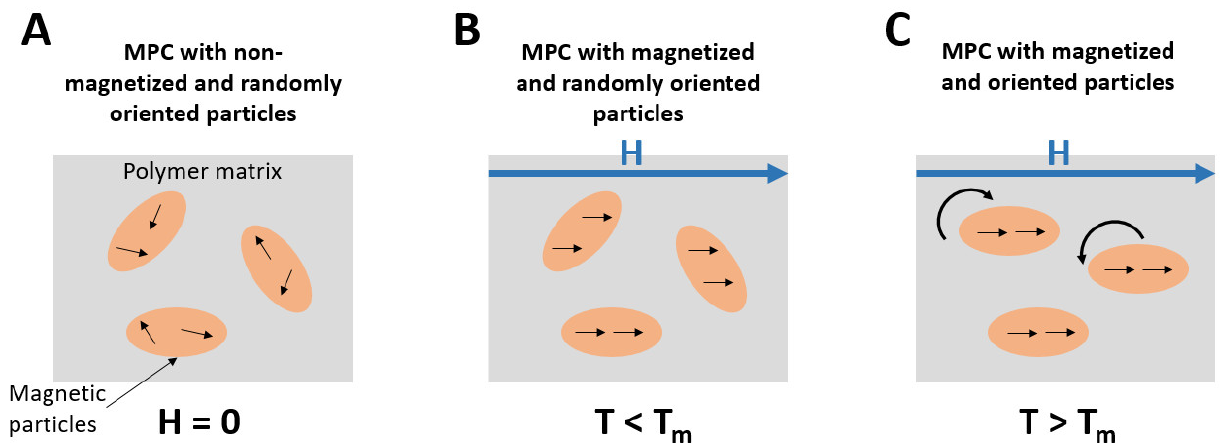
Figure 1. Orientation of the magnetic particles in the MPC under different conditions: ( A ) randomly oriented particles embedded in the polymeric matrix without any applied field (H = 0) and temperature under the melting temperature of the polymer (T m ); ( B ) when an magnetizing field strong enough (H > H s ) is applied and the temperature is under the melting temperature of the polymer, the particles are magnetized but not oriented; ( C ) when a strong enough magnetizing field (H > H s ) is applied and the temperature is over the melting temperature of the polymer, the particles are magnetized and oriented in the direction of the magnetizing field.